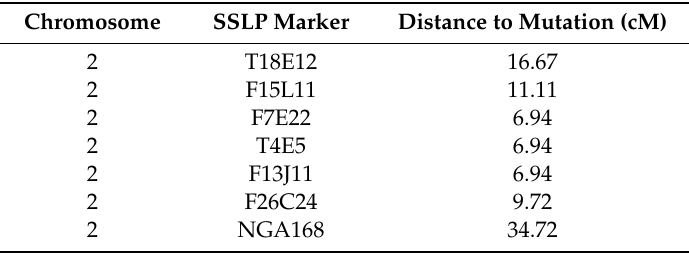
Table 3. Marker-assisted mapping of ewe1 (2).